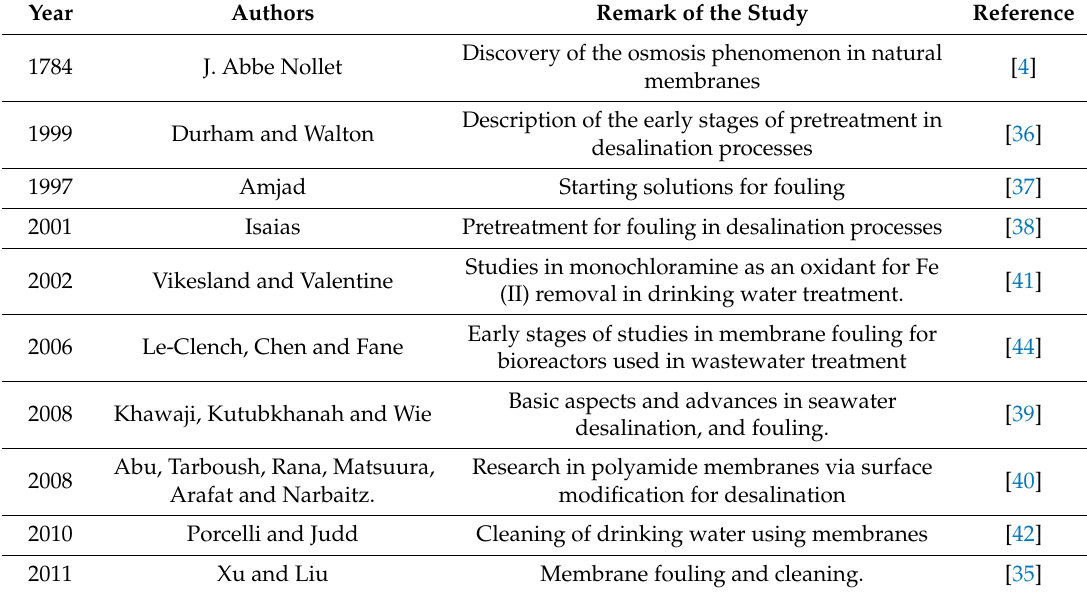
Table 3. Remarkable studies regarding membrane fouling from early